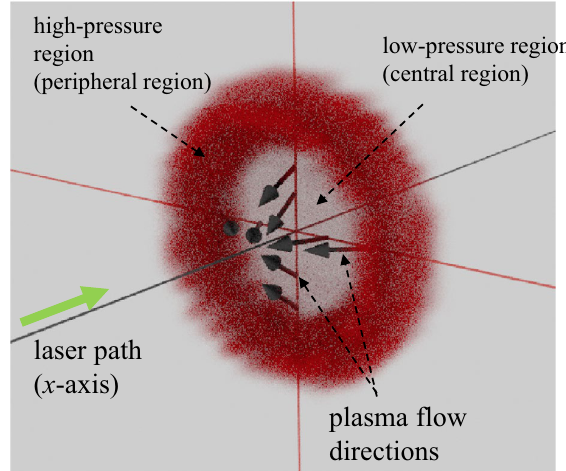
Figure 4. cartoon of the 3D pressure profiles and plasma inflow of the EUV source